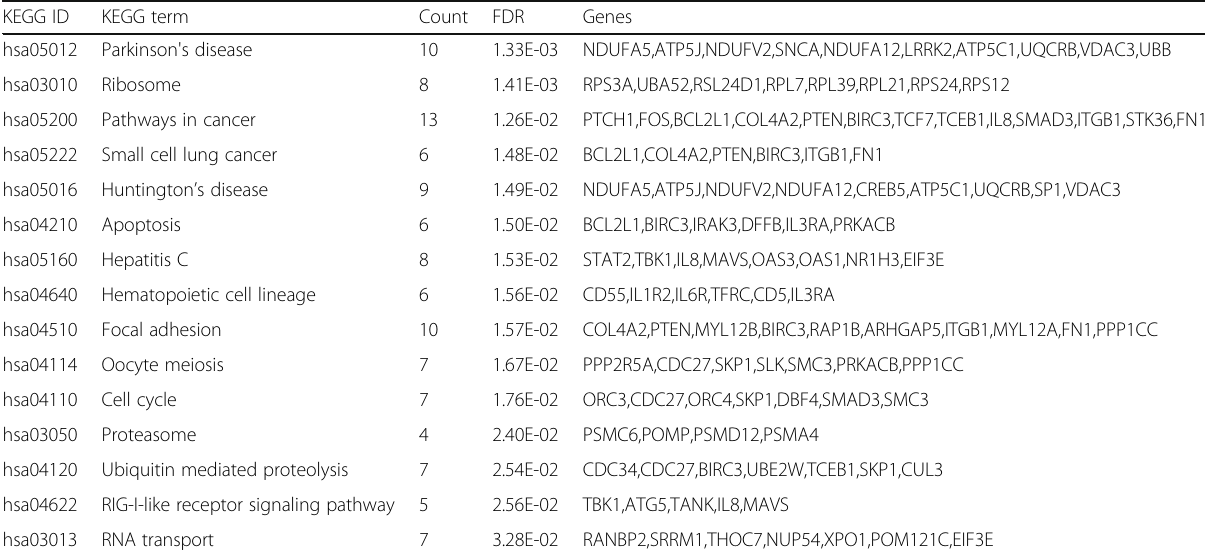
Table 1 The top 15 significantly enriched pathways for differentially expressed genes in T2D KEGG